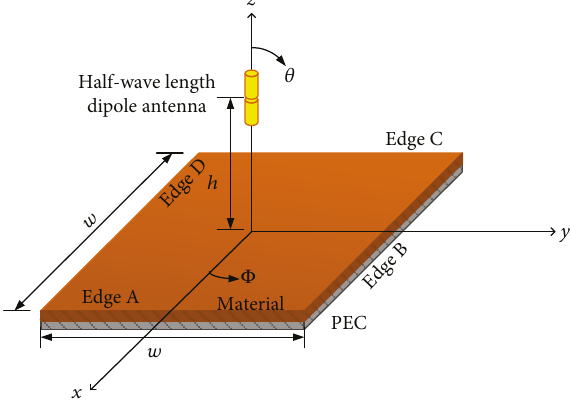
Figure 11: Material-coated PEC square patch excited by a half-wavelength dipole